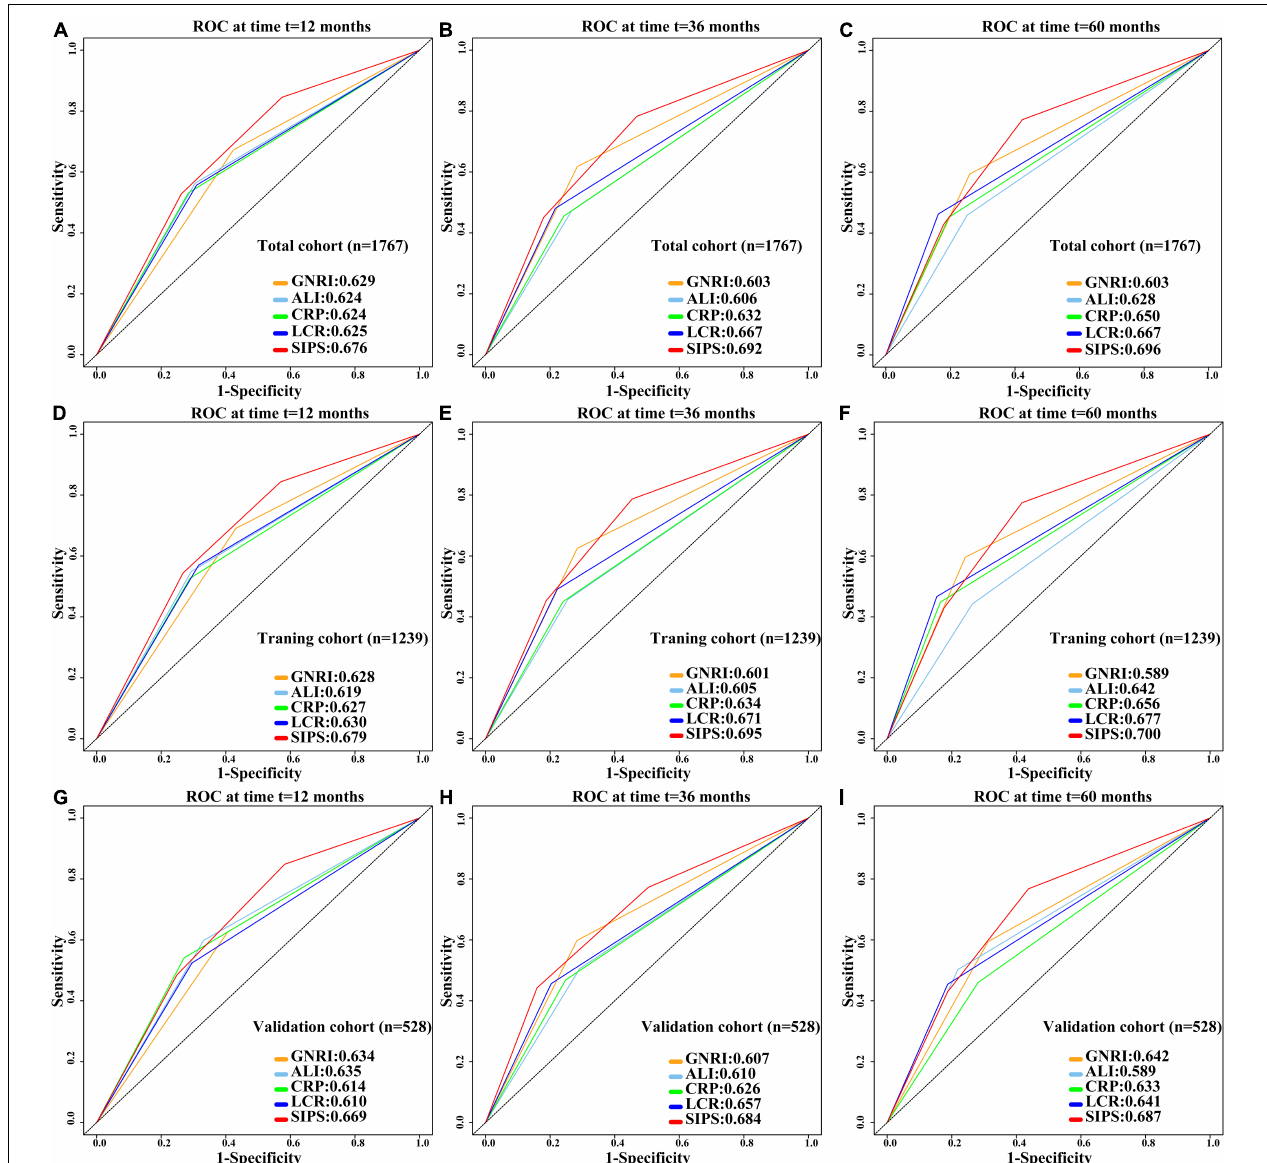
FIGURE 5 | Comparison of 1-, 3-, and 5-year prognostic ROC for SIPS, CRP, GNRI, ALI, and LCR in the total cohort, training cohort, and validation cohort. (A–C) The 1-, 3-, and 5-year prognostic ROC in the total cohort; (D–F) The 1-, 3-, and 5-year prognostic ROC in the training cohort; (G–I) . The 1-, 3-, and 5-year prognostic ROC in the validation cohort. ROC: receiver operating characteristic curve; SIPS: systemic inflammation prognostic score; CRP: C-reactive protein; GNRI: geriatric nutrition risk index; ALI: advanced lung cancer inflammation index; LCR: lymphocyte to C-reactive protein